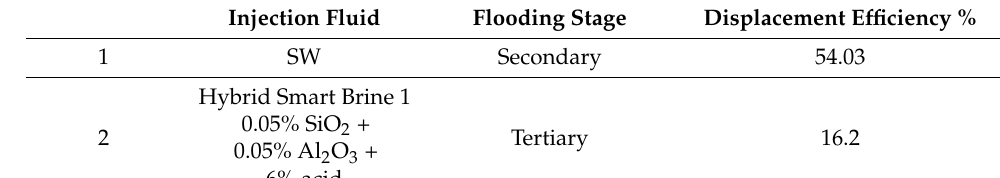
Table 16. Summary of CF9.